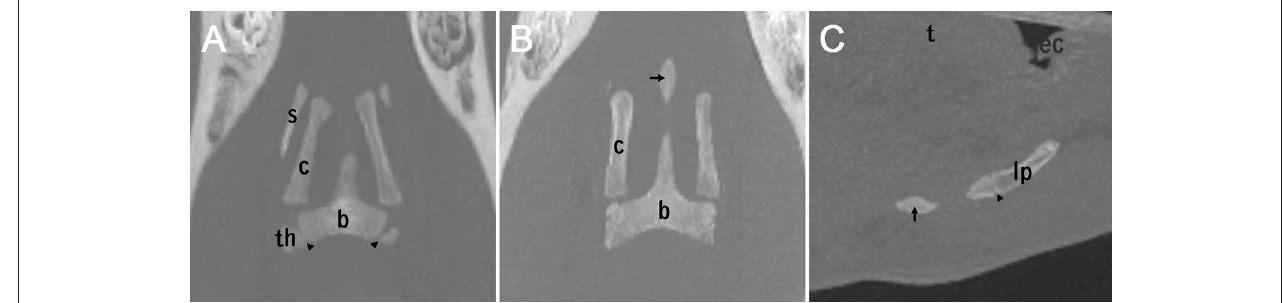
FIGURE 5 | Three different appearances of the lingual process (A,B) : coronary plane (C) : sagittal plane. (A) : non-fully developed lingual process in a 1-year-old horse. The epiphyseal plates of the basihyoid are marked by arrowheads. (B) A separate ossification center of the lingual process (arrow) in a 2-year-old horse. (C) A separate ossification center of the lingual process (arrow) and an growth plate of the lingual process (arrowhead) between the second ossification center of the lingual process and the basihyoid, in a 2-year-old horse. The epiglottis is indicated with ec (epiglottic